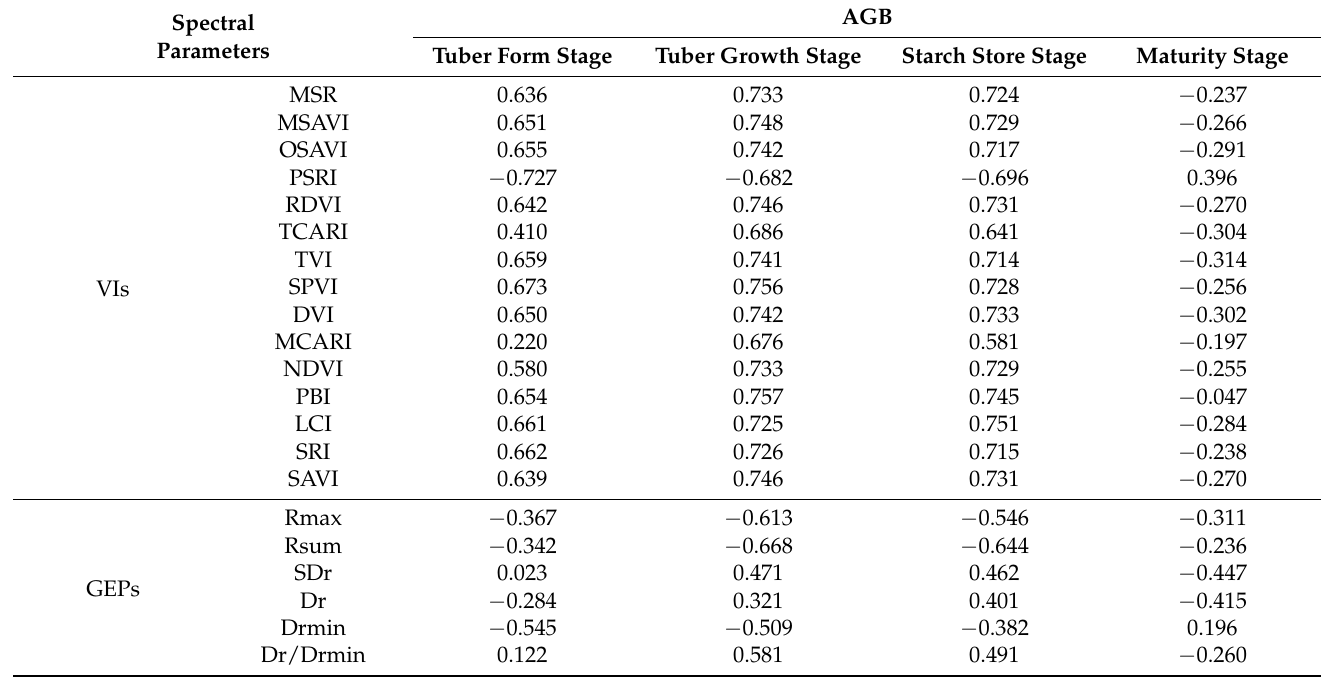
Table 2. Correlation coefficients between (i) VIs and GEPs and (ii) AGB for the four potato growth